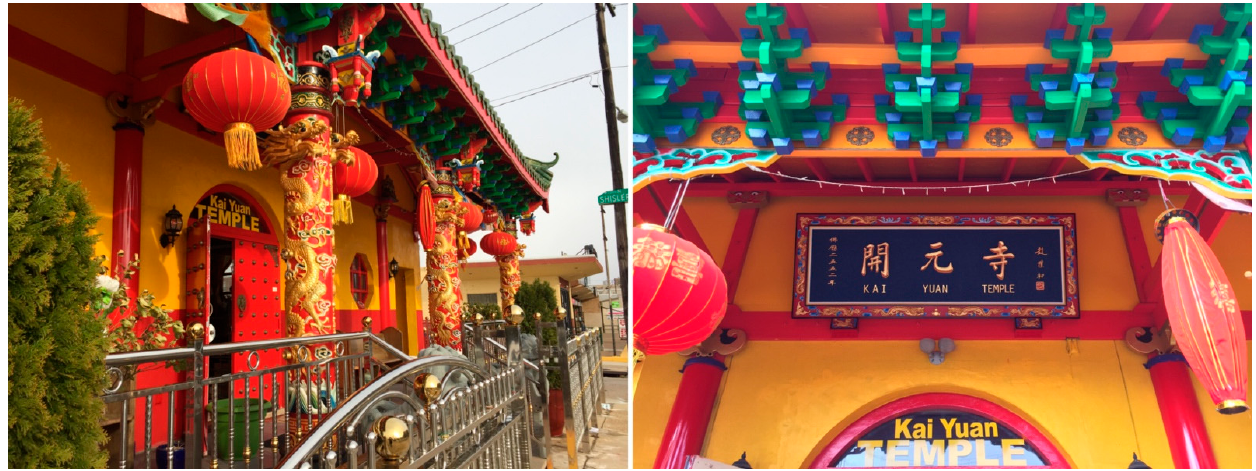
Figure 1. Two views of the façade of Kaiyuan Temple, in northern Philadelphia. Source: www.jivaka.net/philly (accessed on 4 June 2021), Creative Commons license.